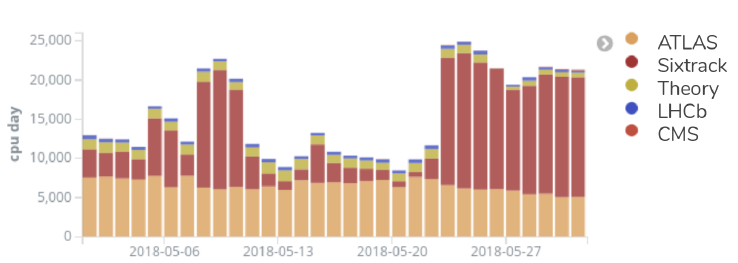
Figure 1. CPU consumption in CPU days per app on LHC@Home in May